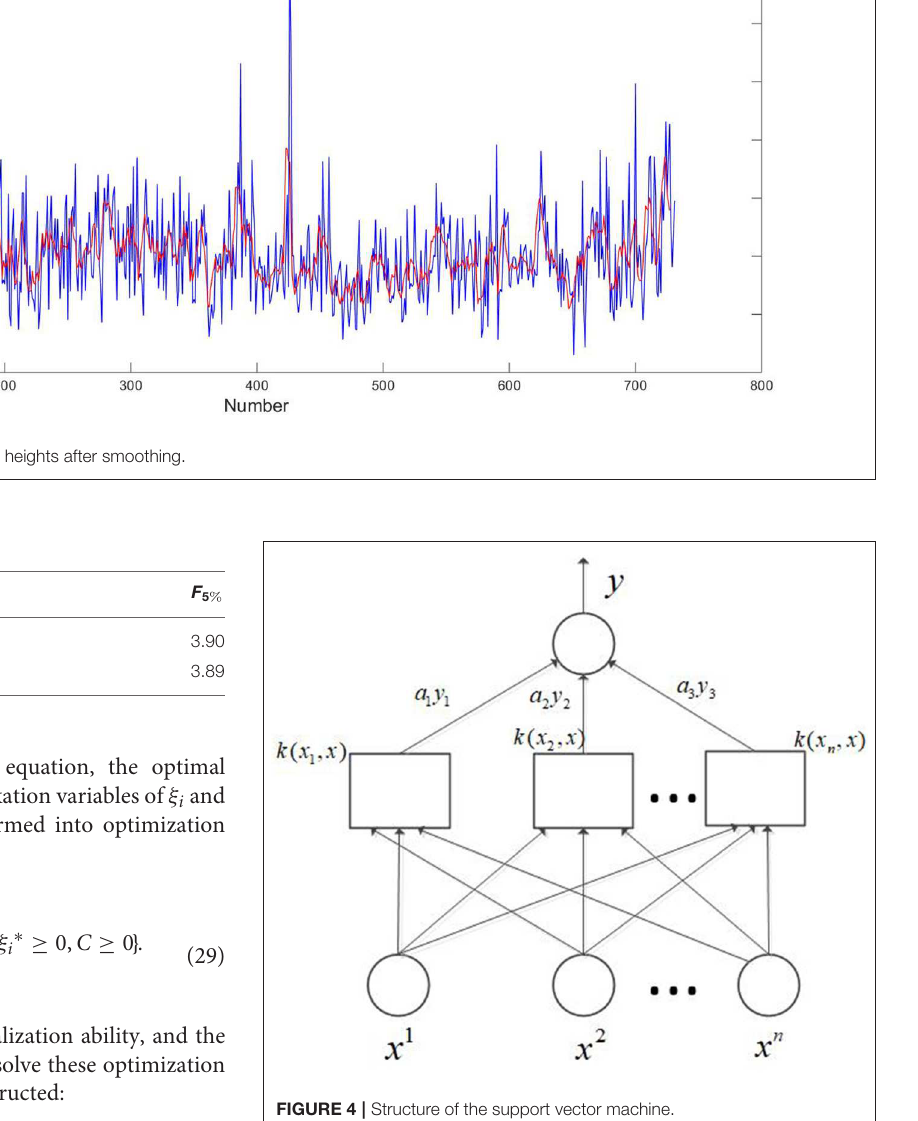
FIGURE 4 | Structure of the support vector